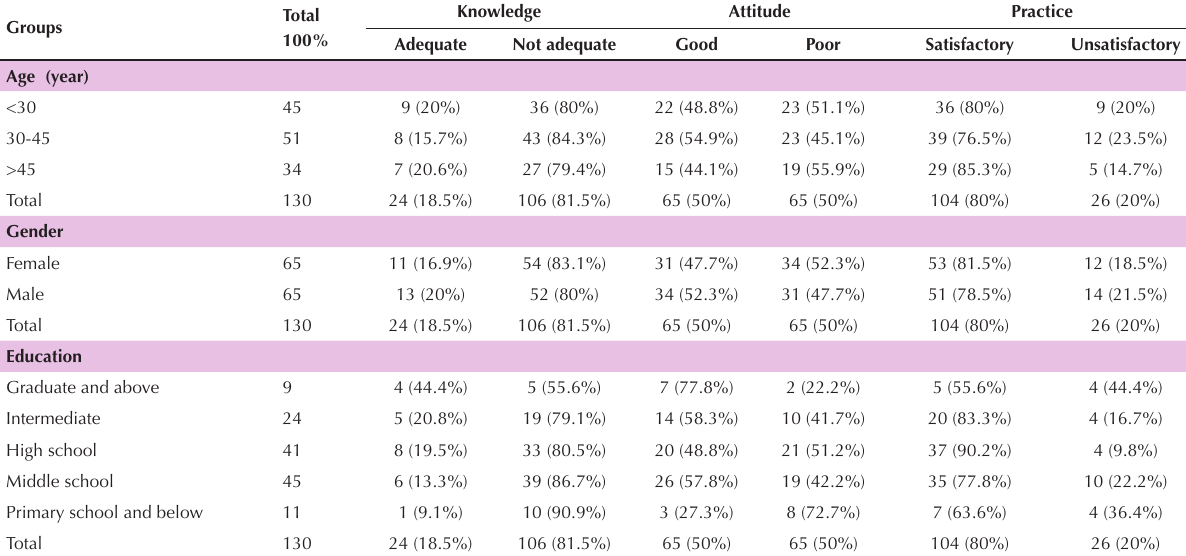
Table 1. Response to the knowledge, attitude and practice of respondent groups